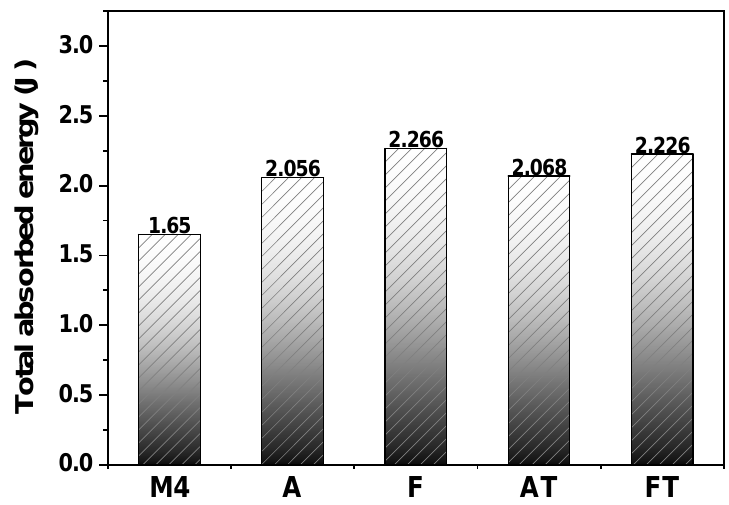
Figure 8. Total absorbed energy of the post-heat treated M4.